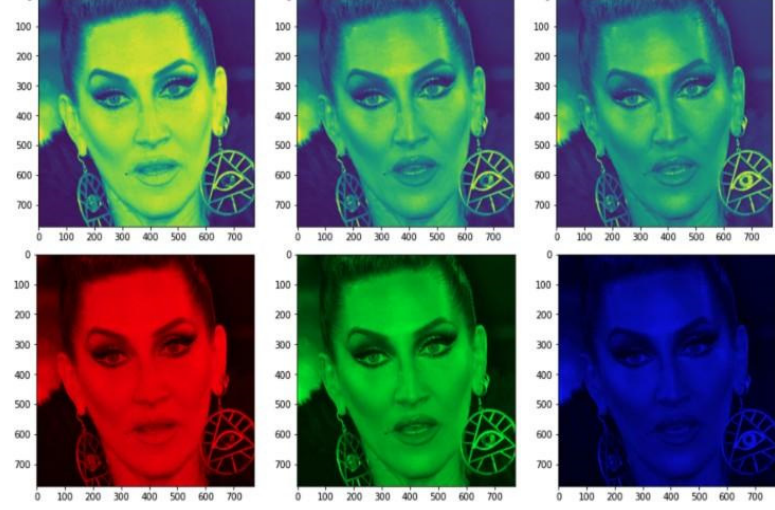
Figure 6. Pixel values for each channel are visualized using the zero matrices.